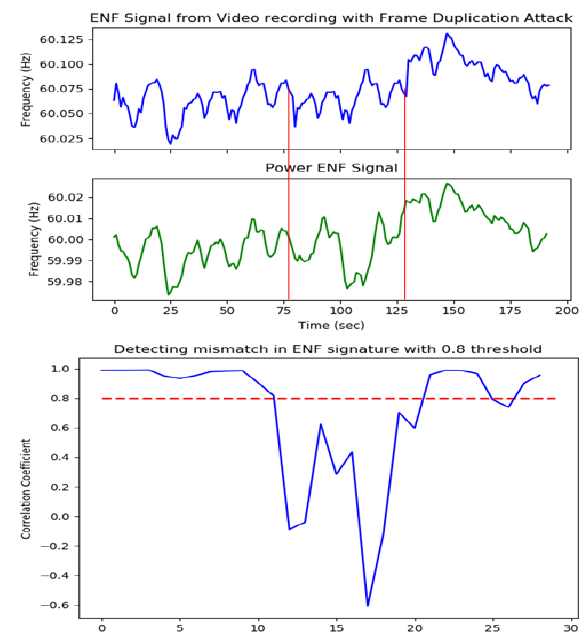
Figure 12. Detection of Video Forgery Attacks on the Surveillance system using the proposed EVAS model. The correlation coefficient is compared to the threshold 0.8.